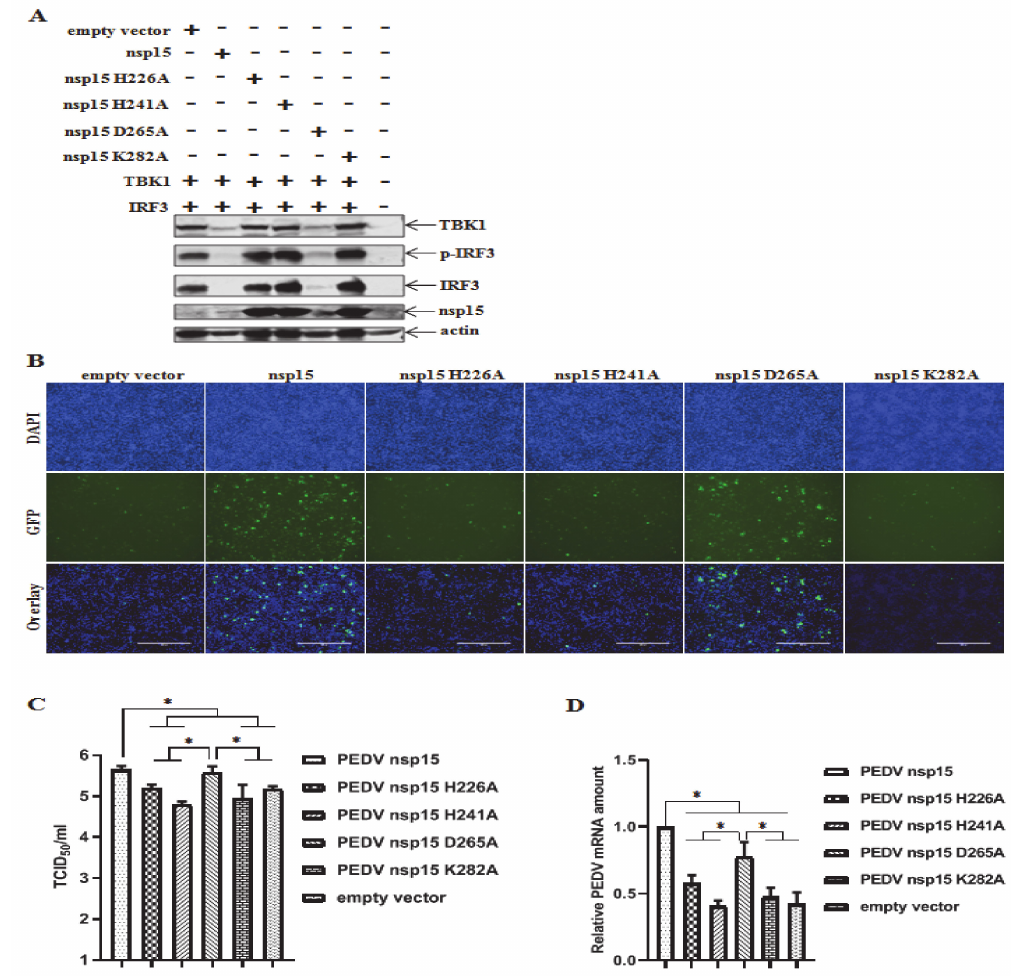
Figure6. PEDV nsp15 inhibitsIFN production dependent on its endoribonuclease activity. ( A ) HEK293T cells were co-transfected with TBK1 (HA tagged, 0.6 µ g) and IRF3 (flag tagged, 0.6 µ g) along with 0.6 µ g of nsp15 expression plasmid (flag tagged, PEDV nsp15, H226A, H241A, D265A or K282A)